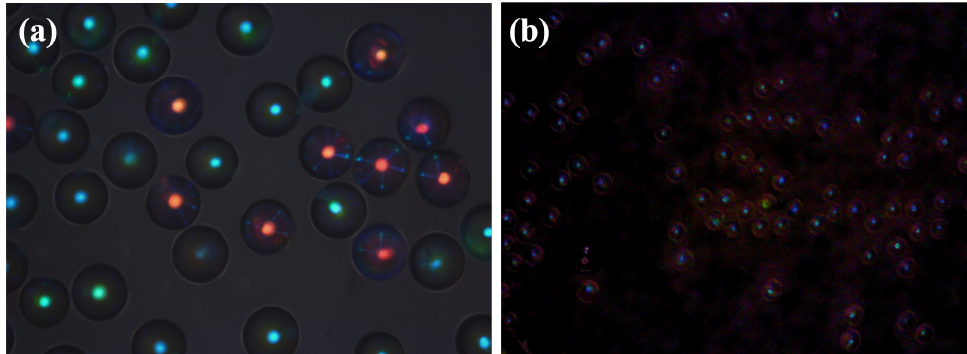
Figure 5. ( a ) CSR response of a Process One tag acquired with the Olympus microscope; ( b ) CSR response of a Process Two tag acquired with the Dino-Lite